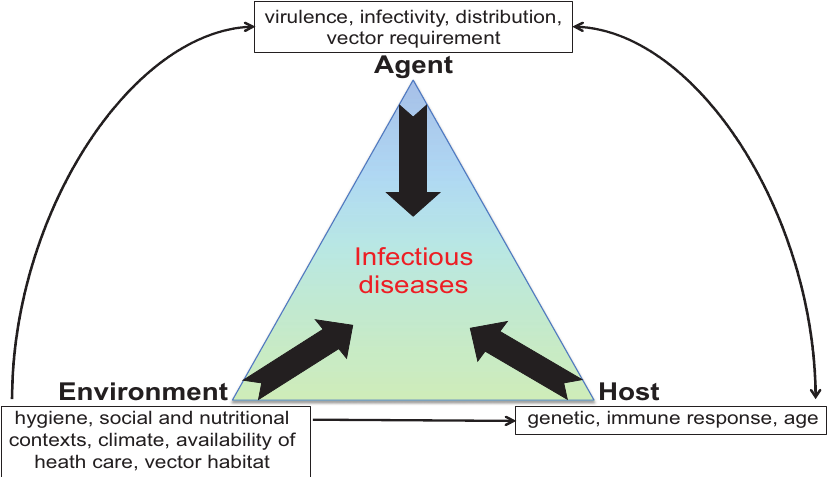
Figure 1. Factors involved in susceptibility to infectious